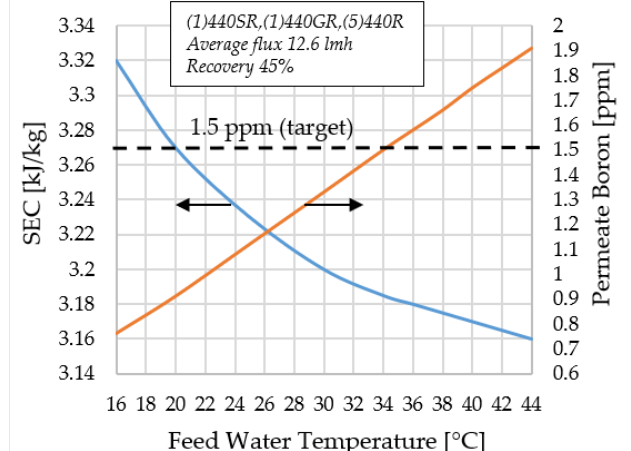
Figure 10. Influence of feed water temperature in the Persian Gulf. Sea water composition from Table